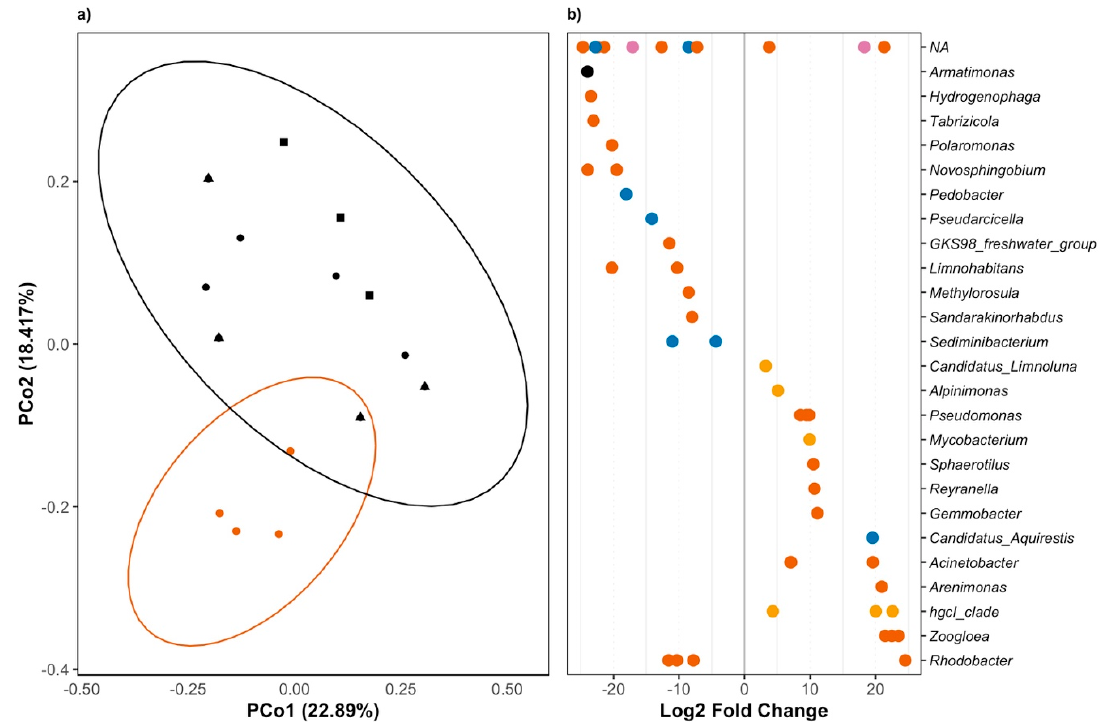
Figure 2. The e ff ect of triclosan on fresh water microbial communities. ( a ) Principle Coordinate Analyses (PCoA) of unweighted UniFrac scores shows significant dissimilarity between microbial communities exposed to 10,000 ng / L (shown in red circles) compared to communities exposed to 10 ng / L (black lozenges), communities exposed to 1 ng / L (black triangles), and controls communities (ADONIS; Perm = 9999; R 2 = 0.169; F (1,14) = 2.97; adj- P = 0.0002). Axes show the percent variation explained by the principle components estimated from the linear correlation between taxa composition and identity in all samples. ( b ) Changes in ASVs abundance in the presence of 10,000 ng / L of triclosan (DESeq2; P’s < 0.01). Positive fold changes show an increase in the relative abundance of genera in the presence of 10,000 ng / L of triclosan. Genus level classification is provided where available while phyla are shown as follow: Proteobacteria in vermilion; Bacteroidetes in blue; Actinobacteria in orange; Armatimonadetes in black; and Verrucomicrobia in